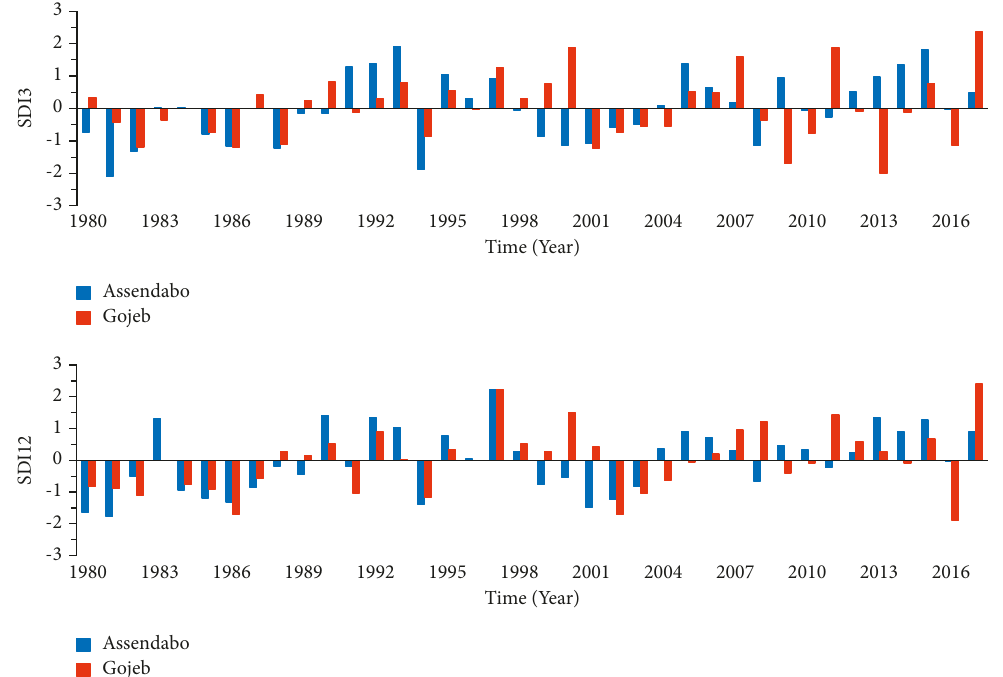
Figure 8: Temporal variation in seasonal (SDI3) and annual (SDI12) for Omo Gibe River basin.